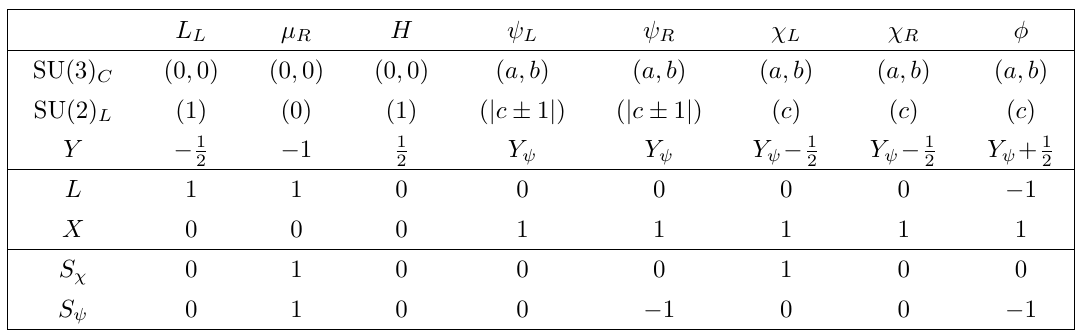
Table 2 . Quantum numbers of fields for Class 2 models. The first two lines give the allowed Dynkin labels for the non-Abelian groups.